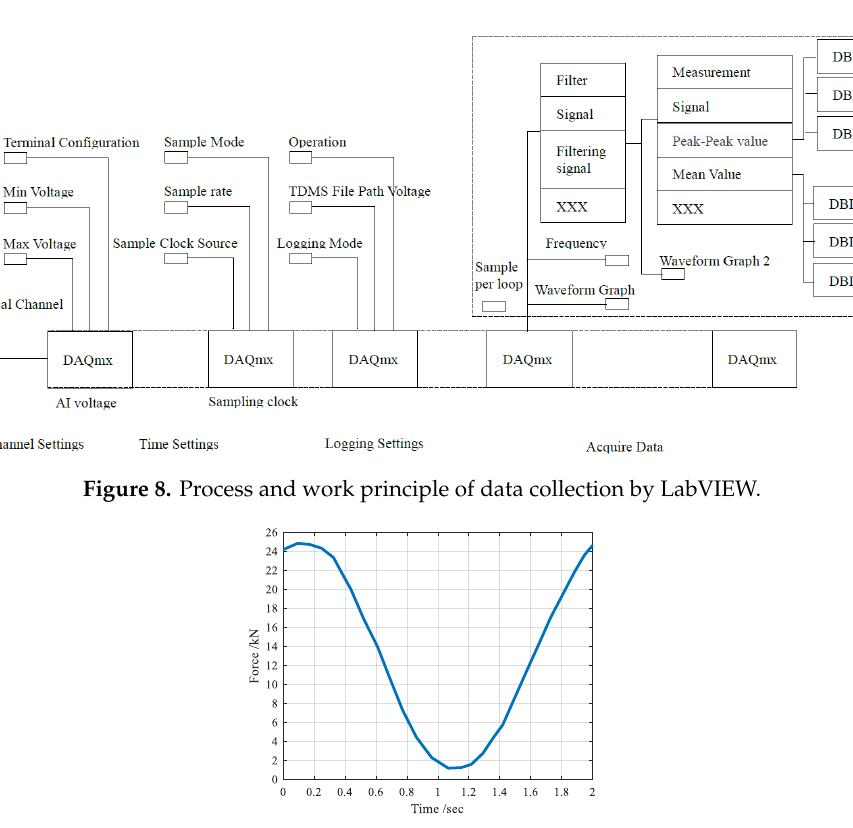
Figure 9. Fatigue load applied to one wire recorded by LabVIEW.